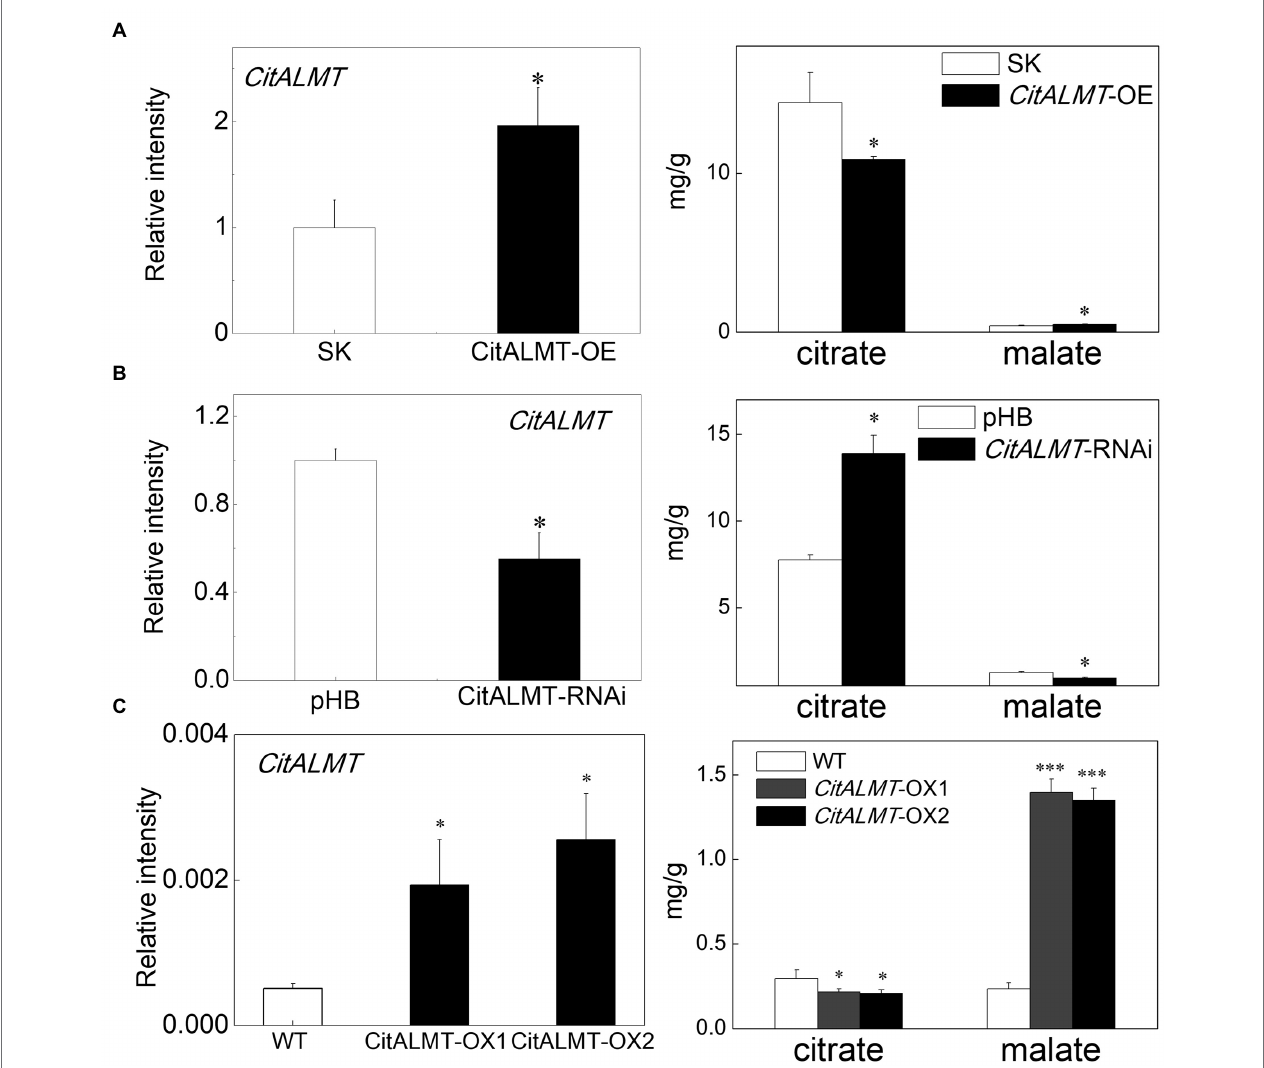
FIGURE 2 | Gene function analysis of CitALMT. The transcript level of CitALMT (left) and organic acid concentration (right) were analyzed in citrus fruits and citrus callus. (A) Transient overexpression of CitALMT in citrus fruits. SK represents empty vector. (B) Transient RNAi of CitALMT in citrus fruits. pHB represents empty vector. (C) The analysis of transgenic CitALMT callus. Error bars indicate SE from three biological replicates. * Significant differences ( p < 0.05), *** Significant differences ( p <